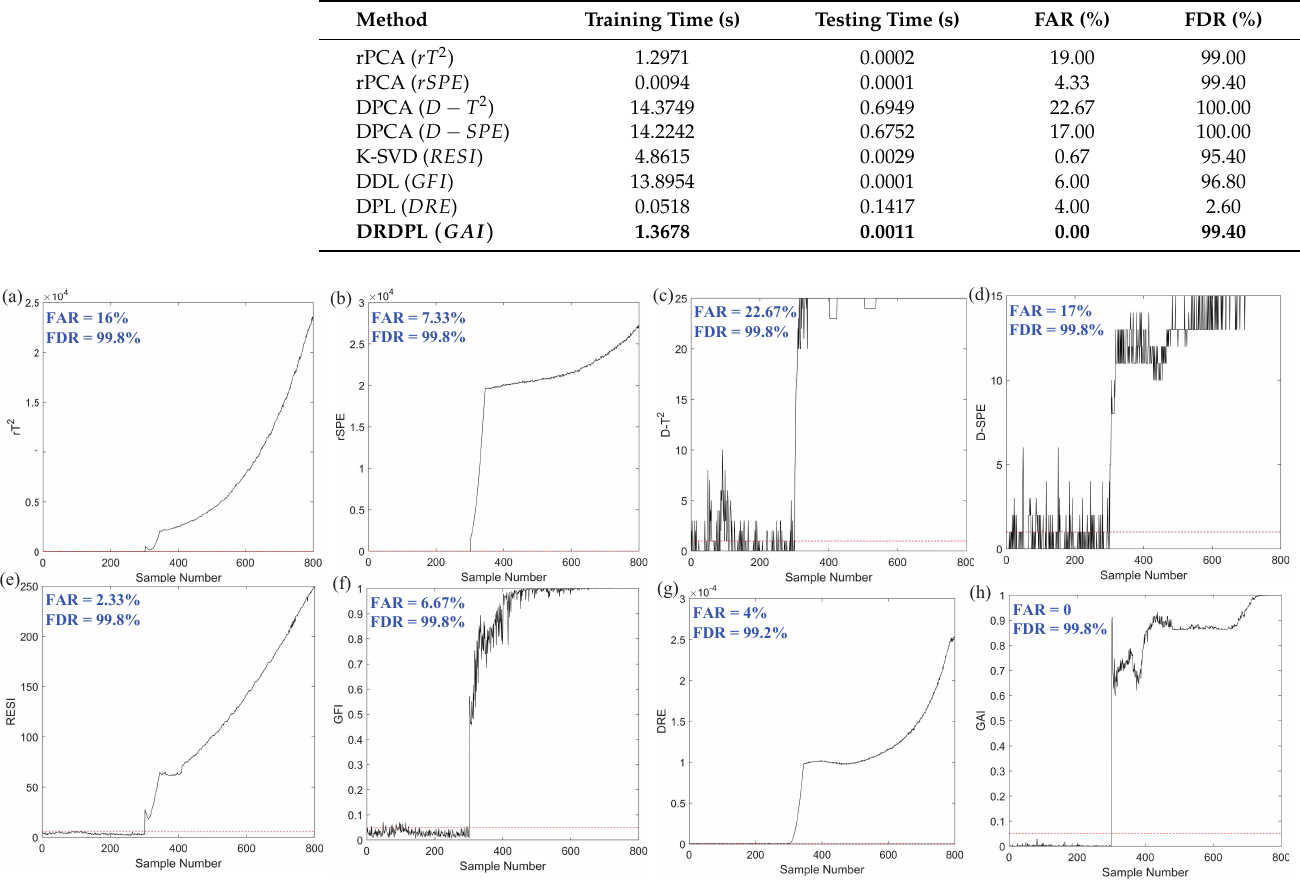
Table 5. The comparison results of TE process with IDV (14).